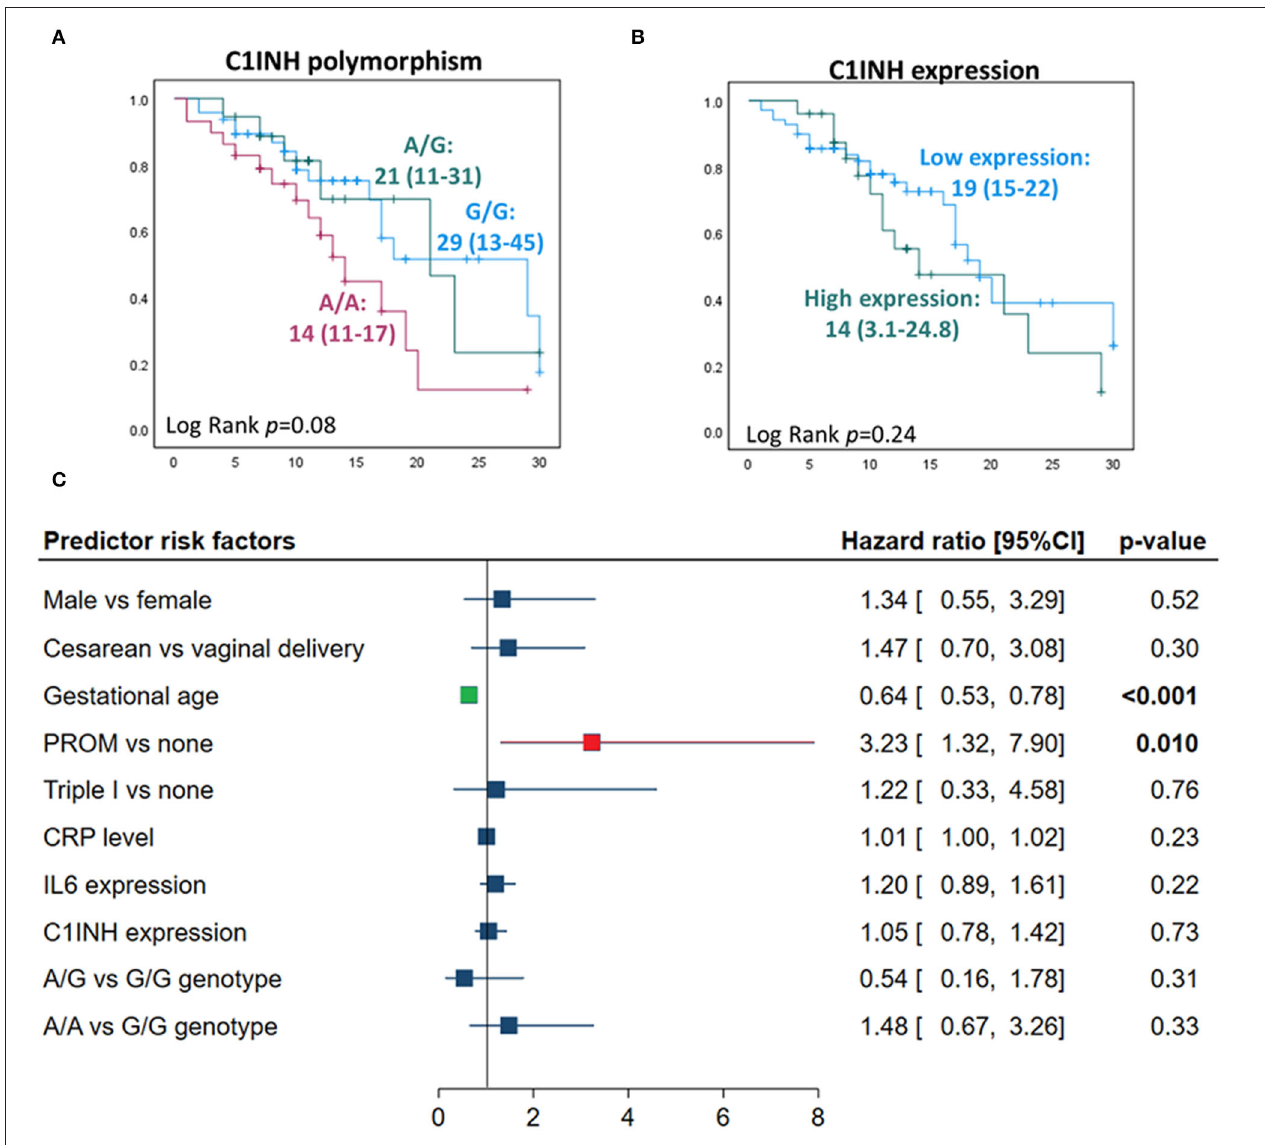
FIGURE 5 | Predictors for mortality in neonatal lung disease patients. (A) Kaplan-Meier curve analysis shows C1INH gene polymorphism rs4926 (G/A) with neonatal mortality. Log Rank (Mantel-Cox) test was used for comparison. (B) Kaplan-Meier curve analysis showing the association of circulatory C1INH gene expression with neonatal mortality. Patients were categorized according to the optimum log fold change of circulatory level of the C1INH gene of − 0.054 into low expression ( n = 67) and high levels ( n = 25). (C) Cox proportional hazards regression analysis revealed independent risk factors for neonatal mortality in neonatal lung disease patients. Hazard ratio and 95% confidence interval (CI) are reported. Correlation analysis was performed to exclude highly correlated variables from the model (absolute correlation coefficient of >